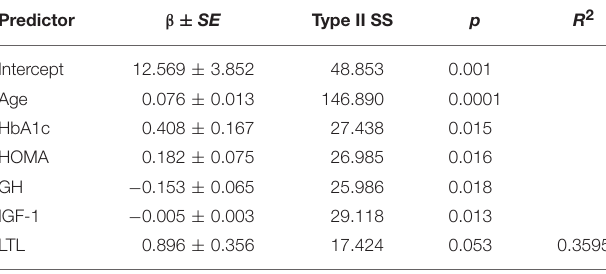
TABLE 5 | Stepwise multiple linear regression analysis of c-f PWV as dependent variable in general group (with adjustment for CVRF). Predictor